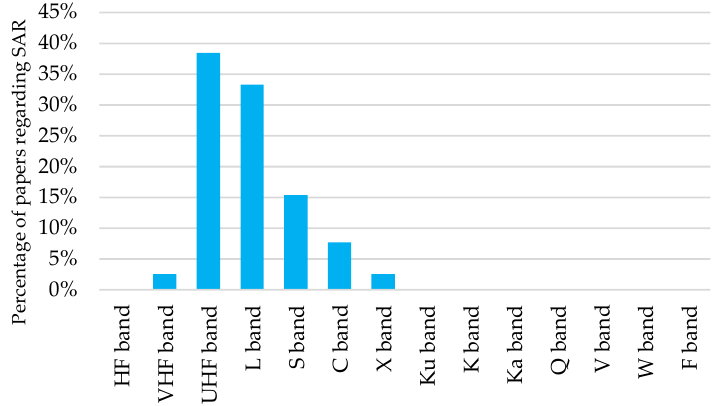
Figure 22. Percentage of papers regarding GPR applications in terms of operative band.